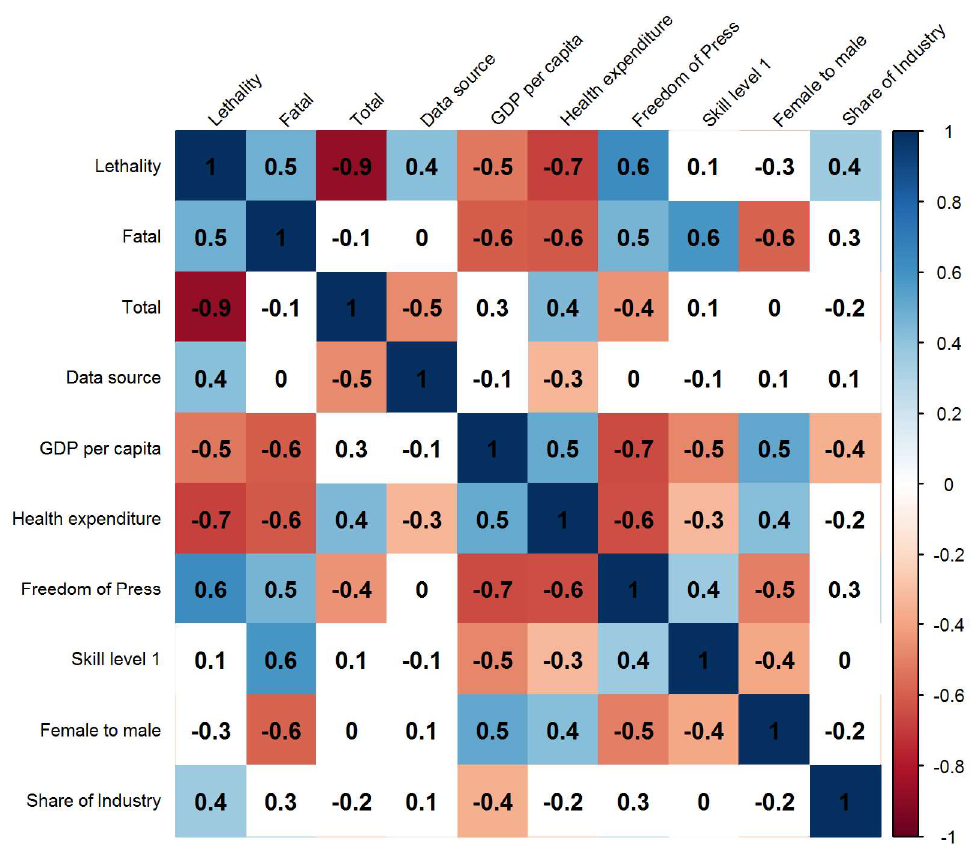
Figure 3. Correlation matrix of summary statistics among 39 countries in 2015. Note: The number indicates the Spearman’s correlation coefficient between two statistics. If there is no colour filled in the box, it indicates that the association between the two variables is not statistically significant ( p -value < 0.005).